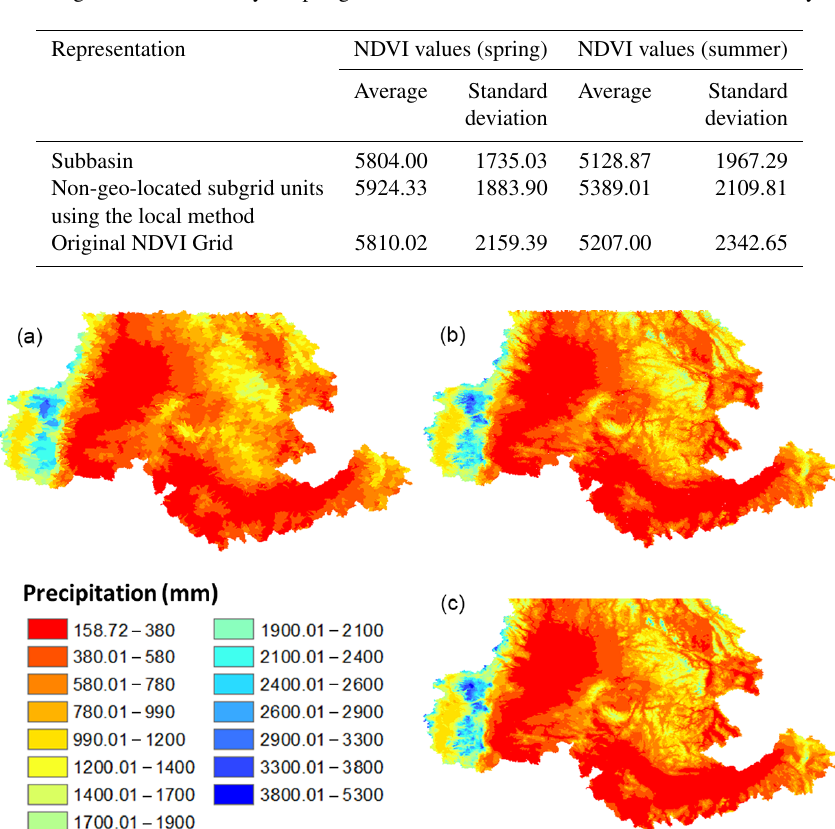
Table 3. Comparing the SUs generated using 3% area threshold from the local method and Subbasin representations against the original NDVI grid representations using statistical summary of spring and summer NDVI values calculated over the study domain.